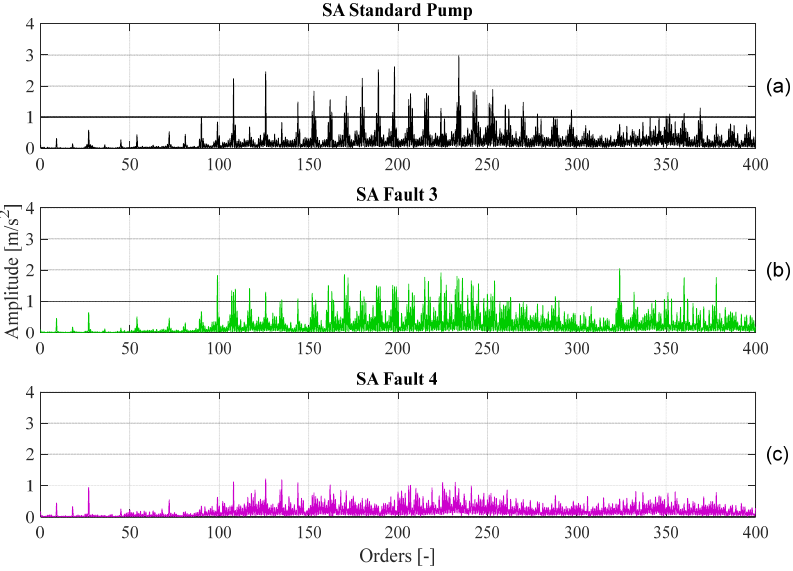
Figure 9. FFT of the synchronous average for ( a ) the standard pump, ( b ) fault 3, and ( c ) fault 4 pump for the signal acquired with sensor 1 (1500 r/min, 150 bar).